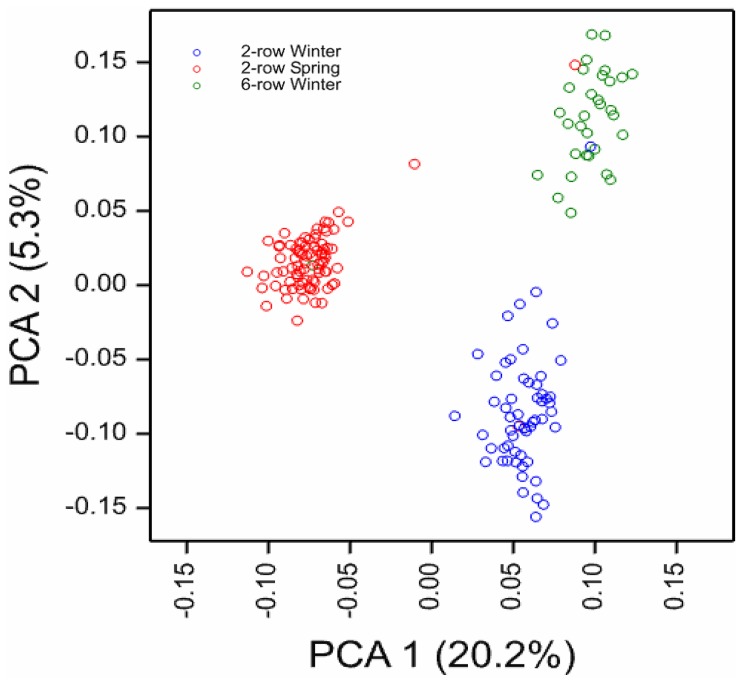
Scatter plot of the first two principal components show the distribution among the cultivars.Cultivars are classified by type: 2-row spring (blue), 2-row winter (red), and 6-row winter (green). The variance explained by each principal component is given in the axis heading.